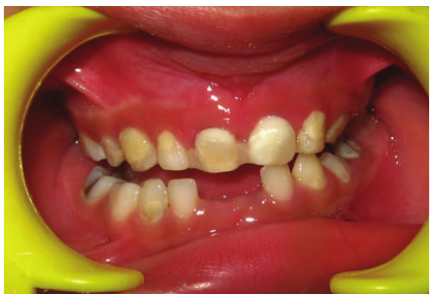
Figure 6: Natural teeth pontics bonded to